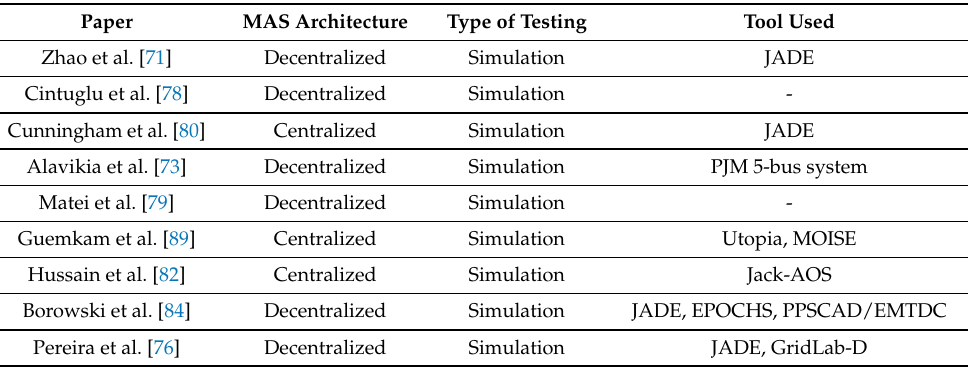
Table 8. MAS-based trust in Smart Grid categorized by other